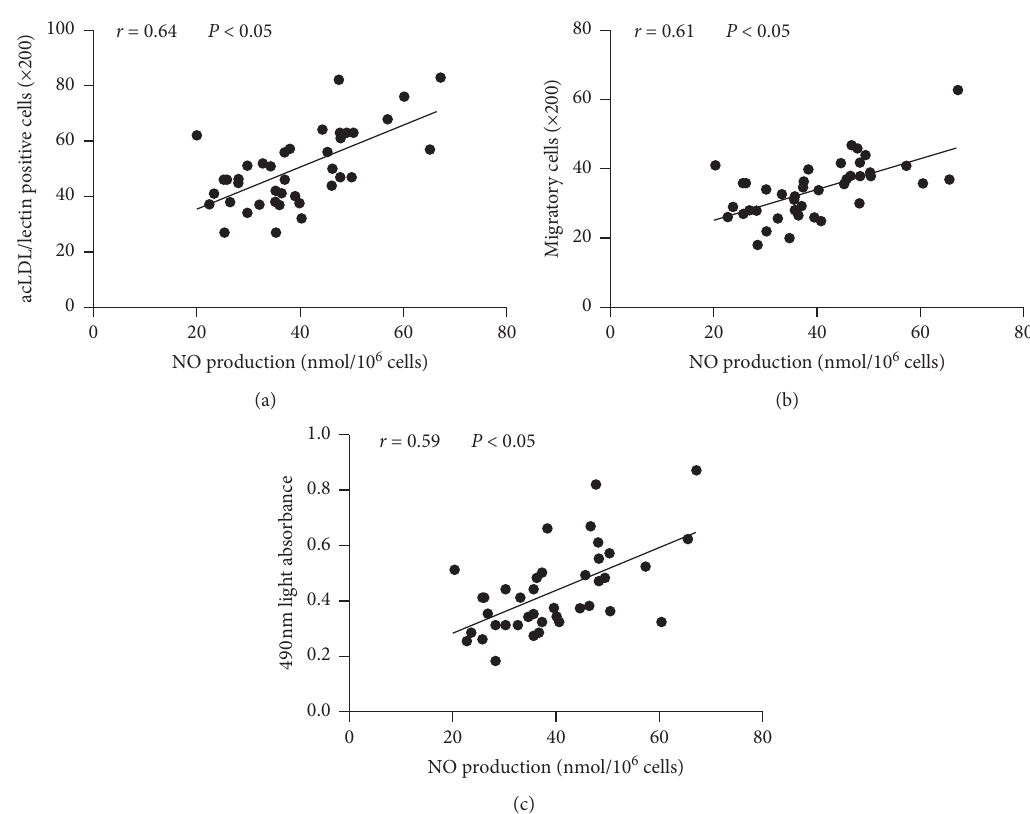
Figure 5: Correlation between the NO level in vitro and the number and activity of circulating EPCs. The linear regression relationship between the NO level in vitro and promoted circulating EPCs in response to 1,25-(OH) 2 D 3 . There was a significant linear regression relationship between the NO secretion level and the number of cultured EPCs (a). There was a significant linear regression relationship between the NO secretion level and the migratory and proliferative activities of EPCs (b),